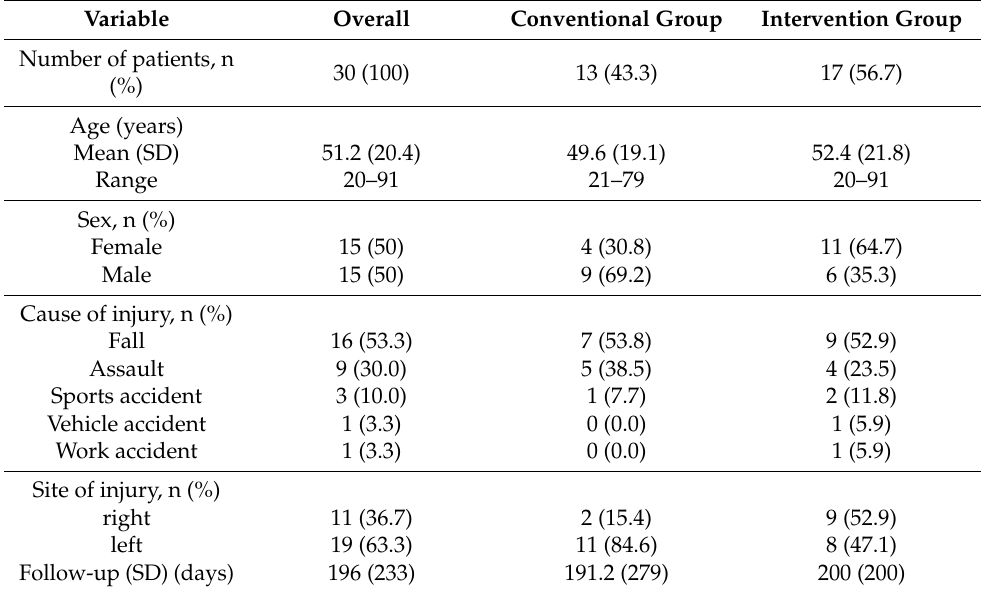
Table 1. Descriptive statistics of the study